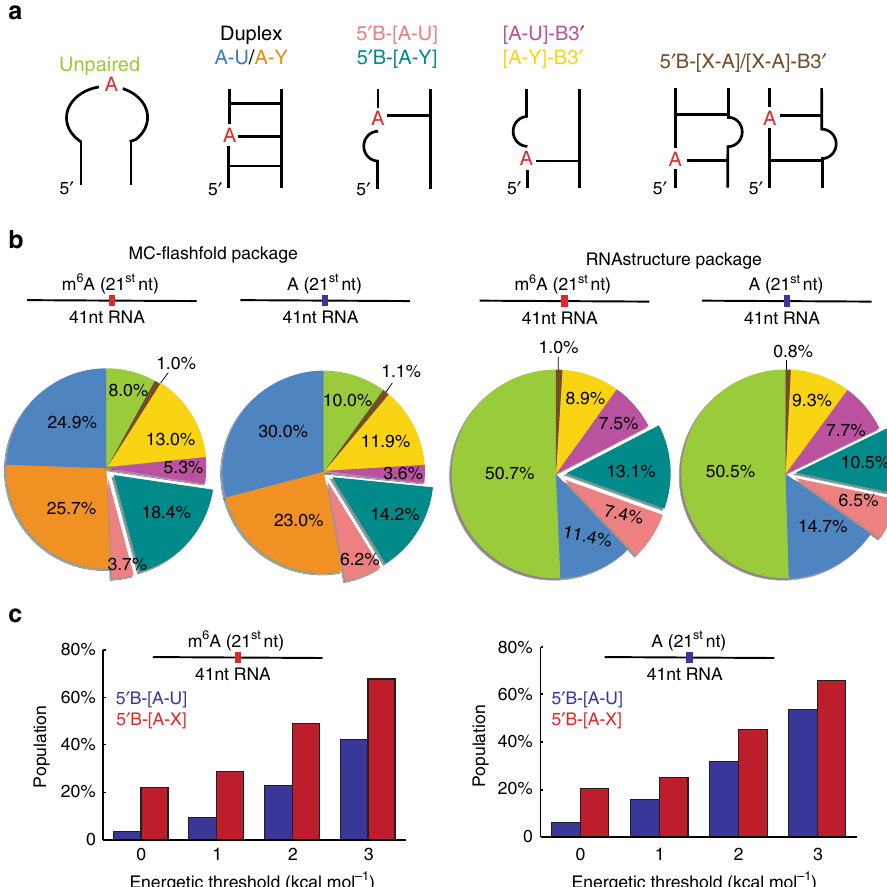
Fig. 3 Predicted secondary structures of m 6 A containing RNA sequences. a Predicted RNA secondary structures were classi fi ed into the following motifs: Junctional Watson-Crick m 6 A – U or mismatch m 6 A – Y (Y denotes A or C or G.) with the bulge located 5 ʹ (5 ʹ B-[A – U] and 5 ʹ B-[A – Y]) or 3 ʹ ([A – U]-B3 ʹ and [A – Y]-B3 ʹ ) to m 6 A; or with the bulge located 5 ʹ or 3 ʹ (5 ʹ B-[X-A]/[X-A]-B3 ʹ , X denotes A or C or U or G) to m 6 A partner nucleotide. b Distribution of